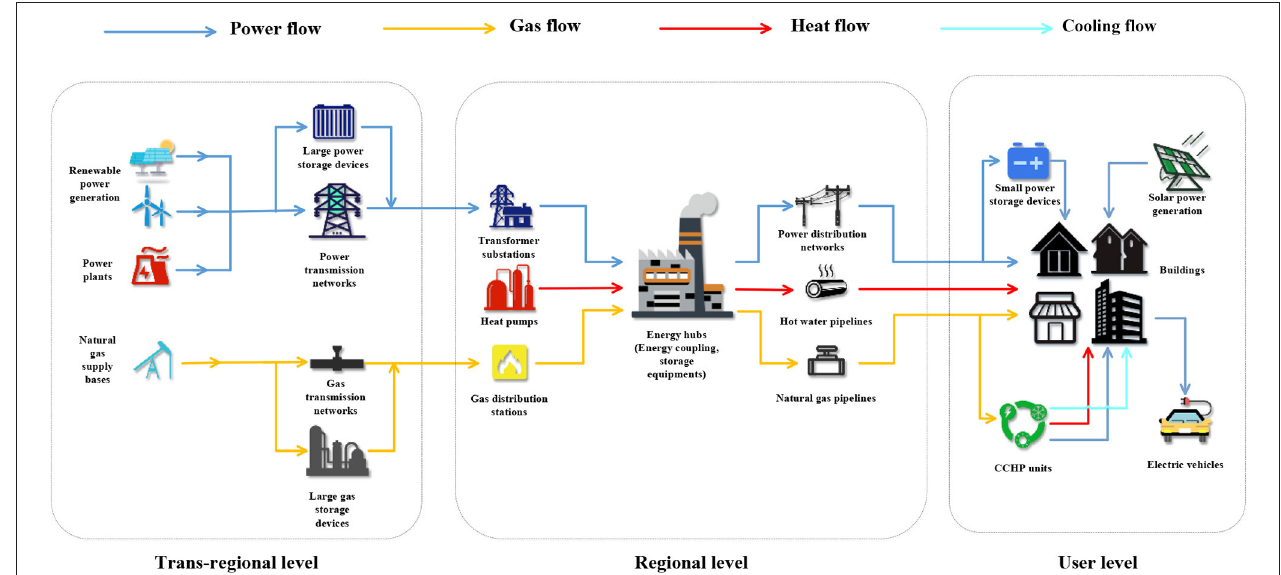
FIGURE 1 | Structure of IES.